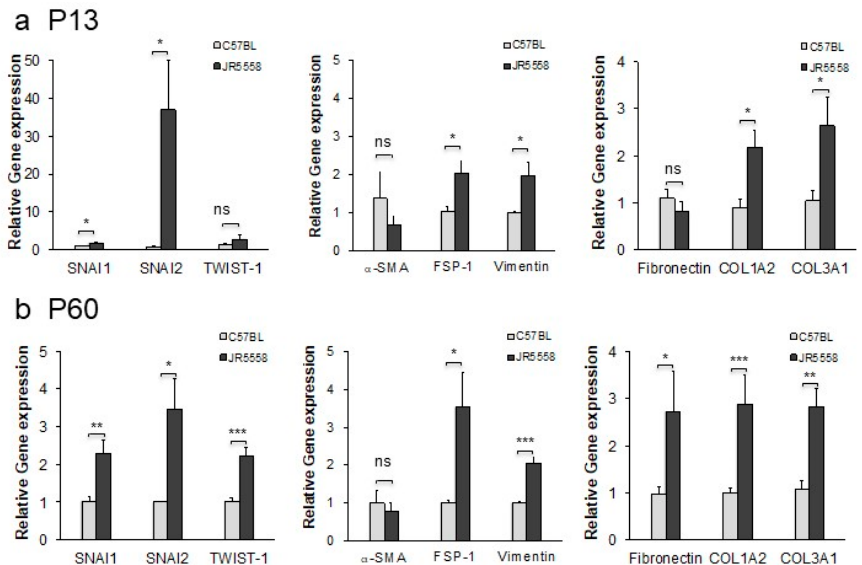
Figure 6. Expression of marker genes for EndoMT in the RPE–choroid of mice with spontaneous CNV is elevated relative to wild-type controls at both P13 and